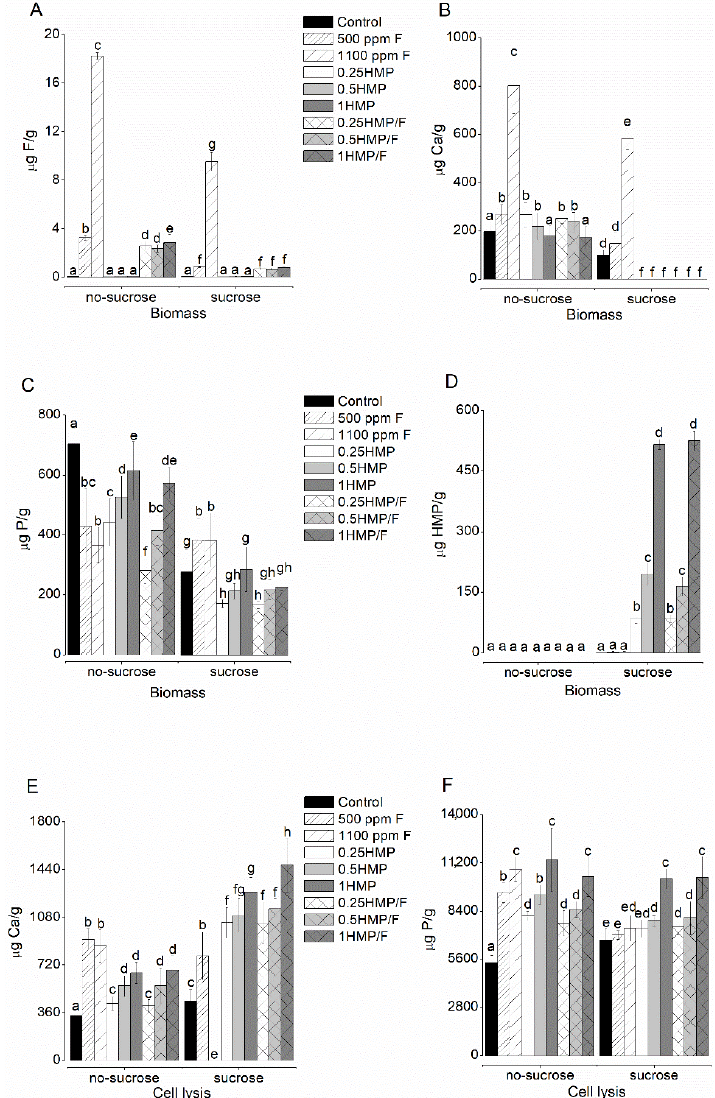
Figure 2. Mean values of F ( A ), Ca ( B ), P ( C ), and HMP ( D ) in the biofilm biomass, and Ca ( E )